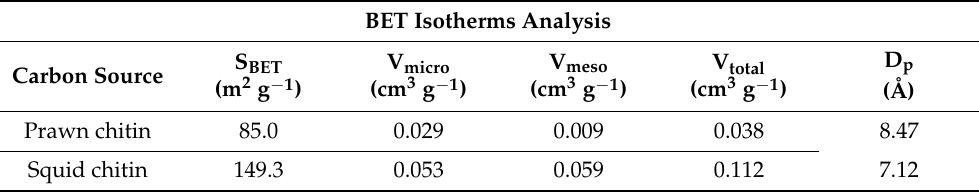
Table 4. BET surface area parameters of the chitin-based carbon